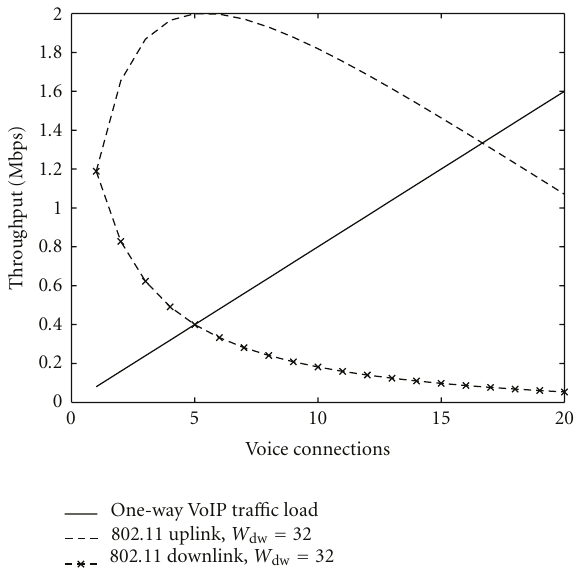
Figure 8: The throughput performance for the scheme without using